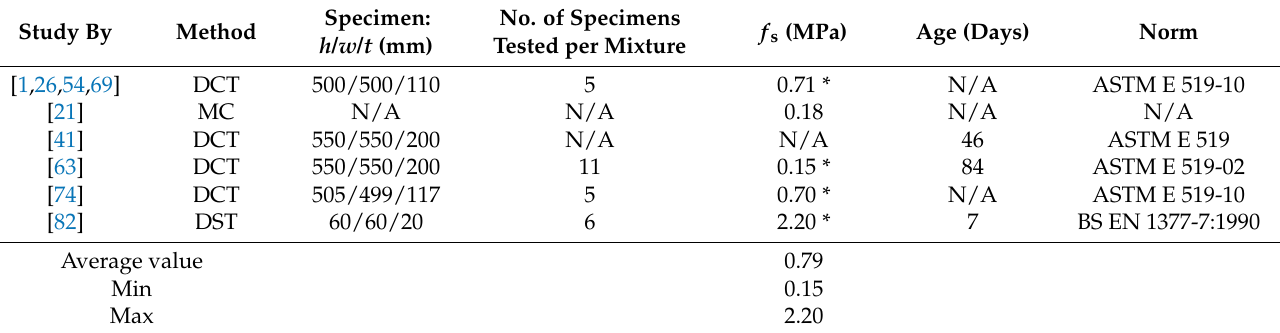
Table 6. Shear strength values obtained at different age, along with description of methods, specimens, and norms employed. Study By